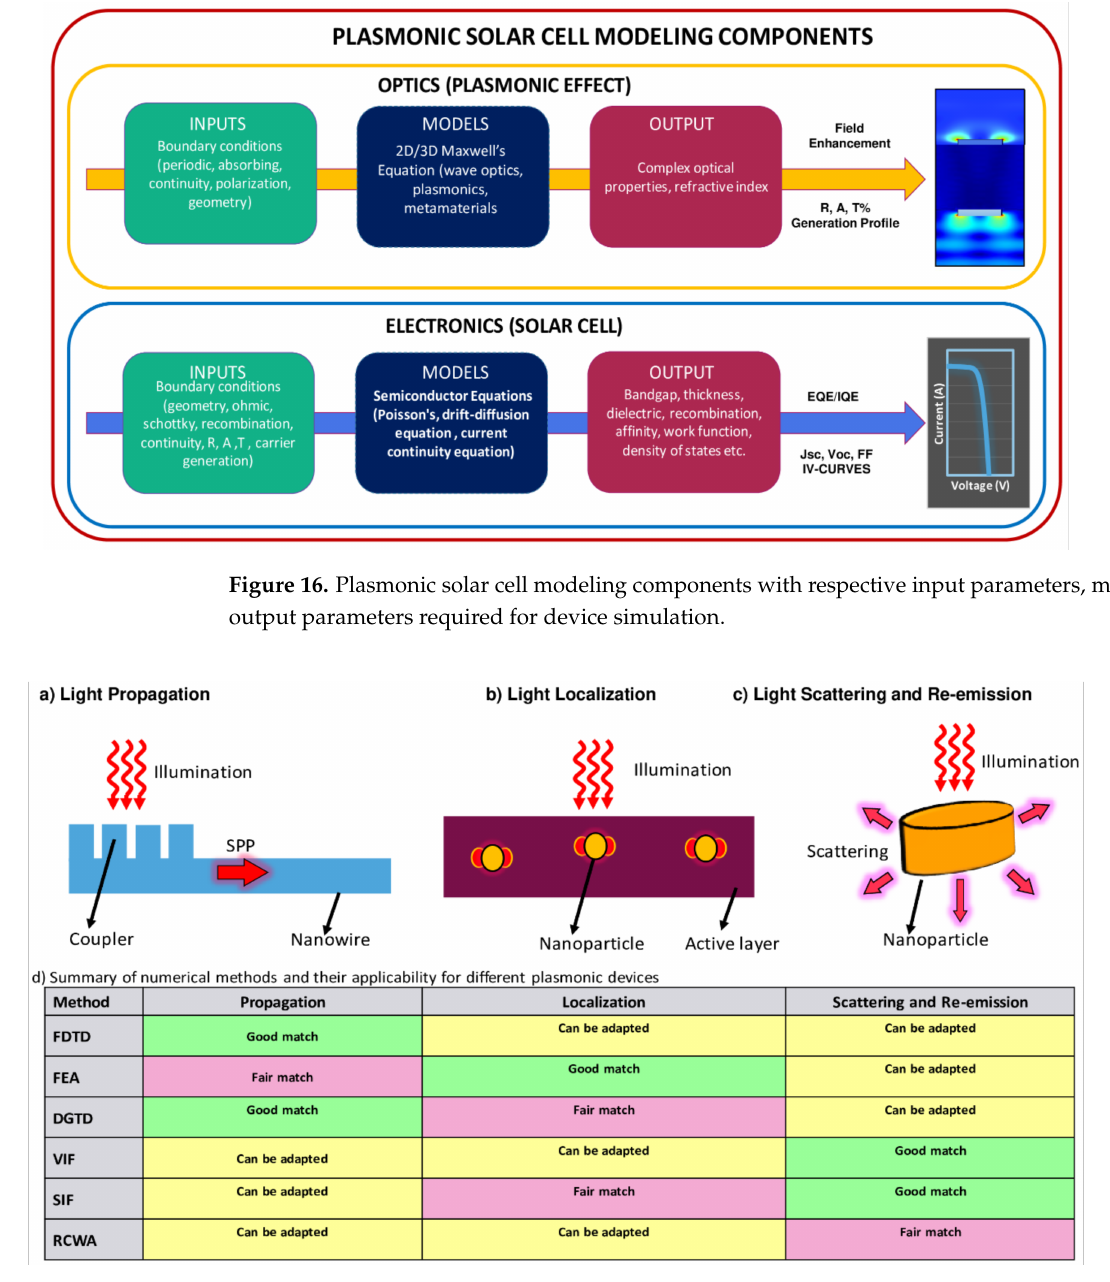
Figure 17. Light mechanisms involved in modeling plasmonic solar cells and comparison of modeling methods